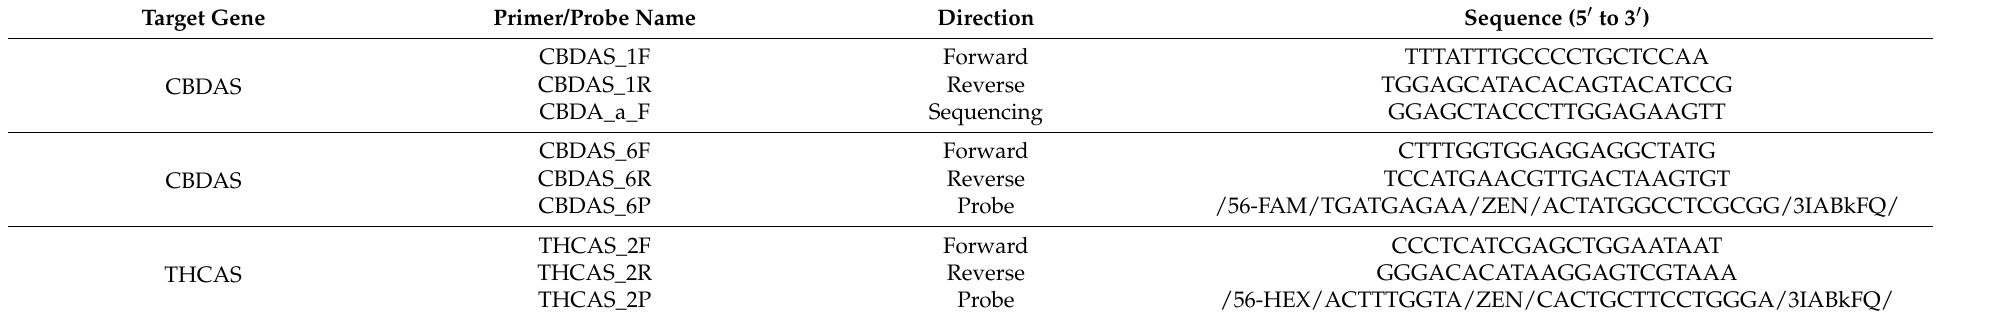
Table 1. Primer and probe sequences used for qPCR in this study to amplify cannabinoid synthase genes in Cannabis sativa